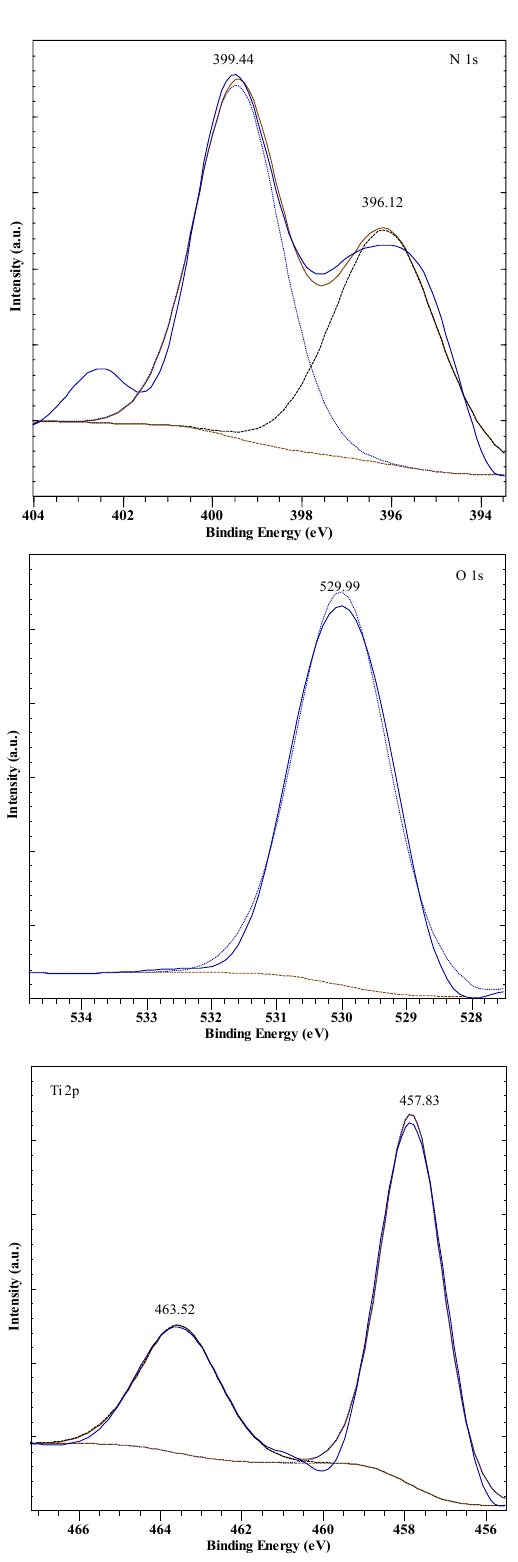
Fig. 2. Selected XPS spectra of N-doped TiO